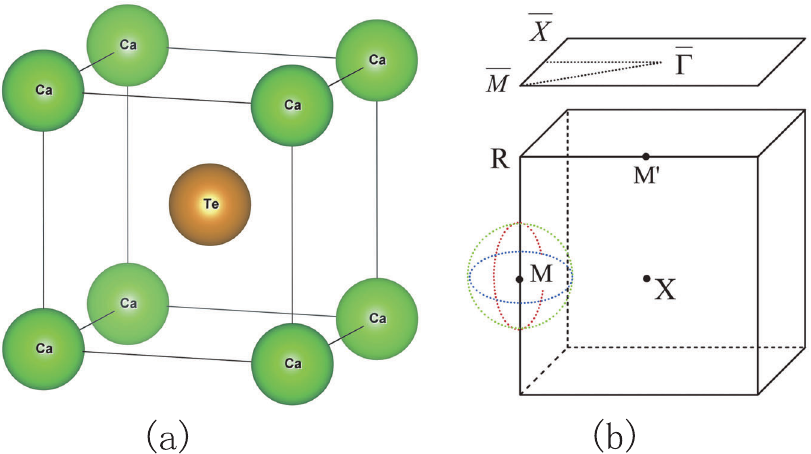
Fig. 1 a Crystal structure of CaTe in CsCl type phase. b The 3D BZ and projected (001) two dimensional (2D) BZ of CaTe. Three dash circles are the scheme of the three line nodes around the M point. The blue circle is parallel to k z = 0 plane, red circle is parallel to k x = 0 plane, and the green circle is parallel to k y = 0 plane